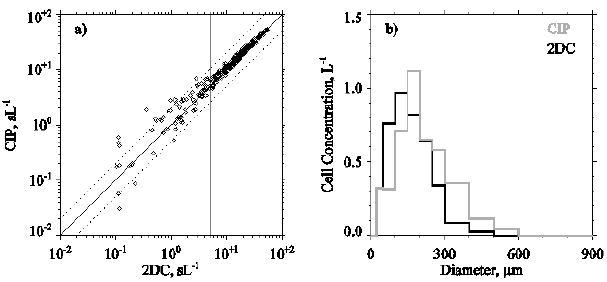
Figure A1. (a) The CIP/2DC concentration comparison. Com- pared values are five-second averages and are for crystals larger than 50µm. Comparison data is from 9 January 2011 during the Colorado Airborne Multi-Phase Cloud Study (CAMPS). Wyoming King Air data shown here was selected from three along-wind level- flight cloud transits: (1) 22:12:00 to 22:22:00UTC, (2) 22:39:00 to 22:48:00UTC, and (3) 23:06:00 to 23:16:00UTC. The verti- cal line at 5sL − 1 is drawn at the median value for our set of 80 WAICO 2DC-derived measurements. (b) 2DC and CIP size dis- tributions from a representative five-second subset (22:46:46 to 22:46:50UTC) of the flight on 9 January 2011.